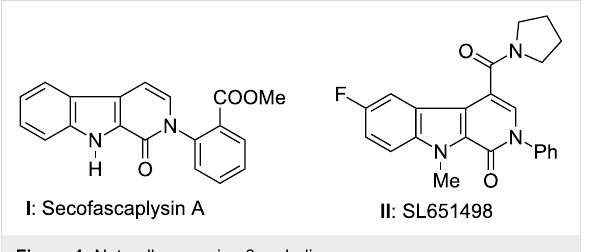
Figure 1: Naturally occurring β